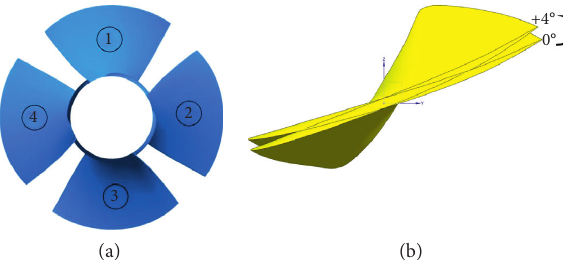
Figure 5: The blade angle distribution. (a) The label of the blade. (b) Blade angle figure.